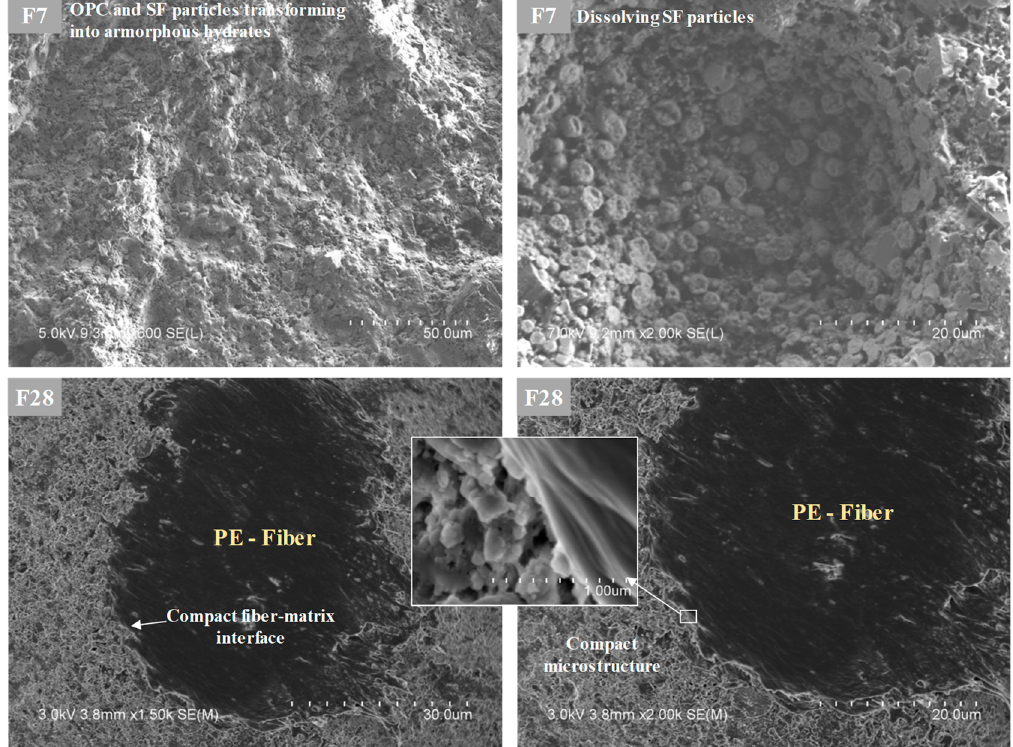
Figure 7. SEM images on the microstructure of specimens F7 and F28.